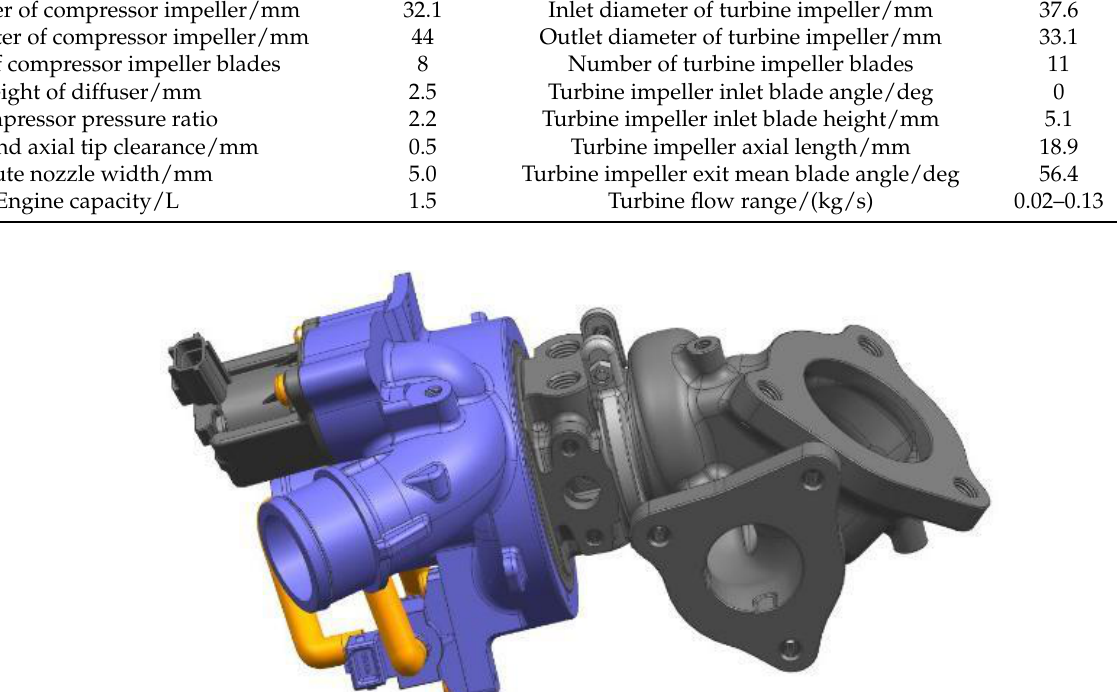
Figure 1. Flow chart of study framework.